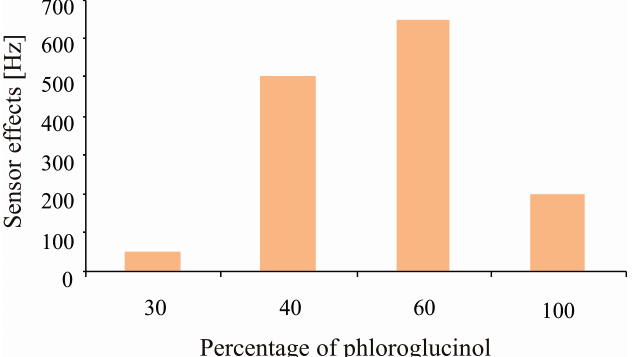
Figure 2. Sensor effects against E2 as a function of phloroglucinol content in